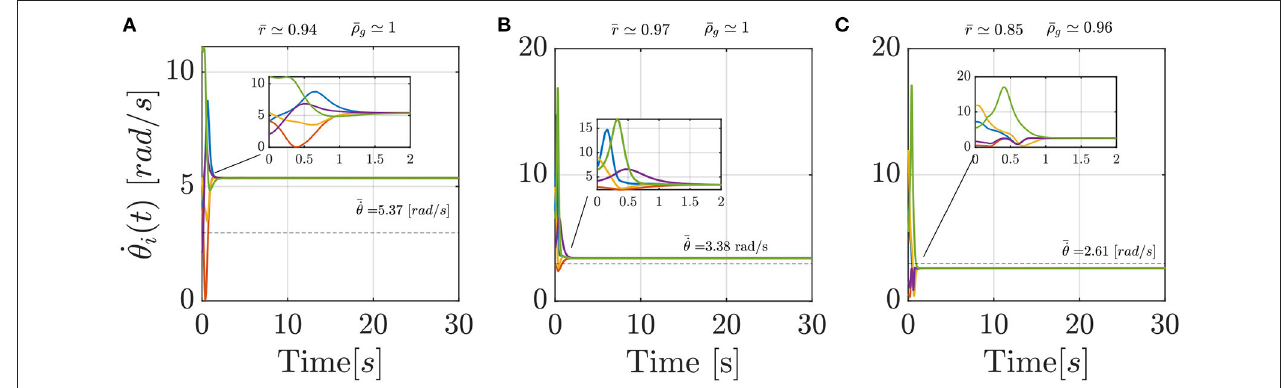
FIGURE 4 | Comparison between three sample simulated trials of the Standard Kuramoto (A) , Model 2 (B) , and Model 3 (C) , respectively. In each panel, the dashed line reports the average experimental group frequency ω exp g whereas on the top the order parameter r and the group frequency index ρ g , in their averaged values, are